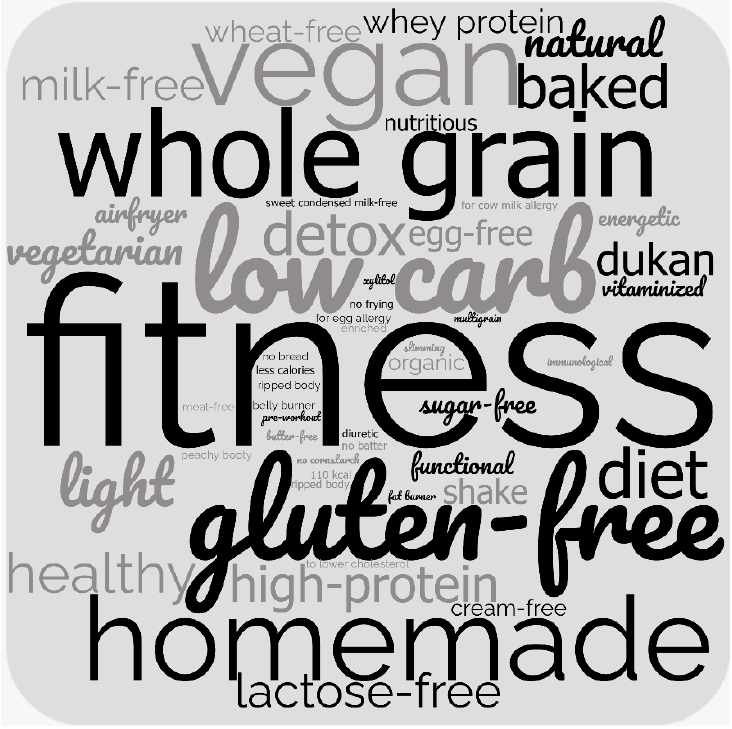
Figure 1. Word cloud generated with codes from content analysis of the titles from 814 culinary recipes available on the ‘healthy eating’ section of a popular Brazilian recipe-sharing website, October 2019–March 2020. The bigger the font-size of each word or expression, the more frequently it appeared in recipes’ titles.